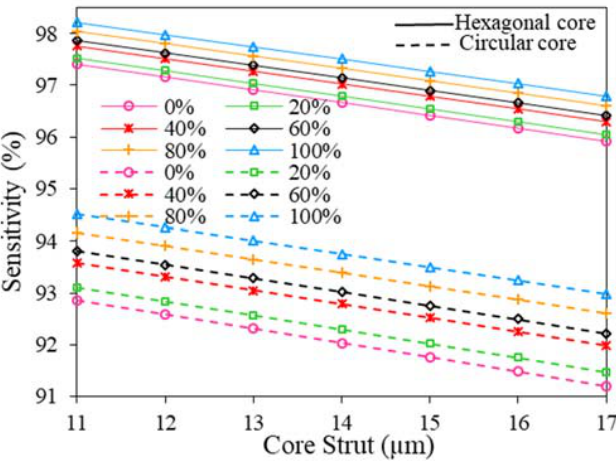
Table 2. RS of the proposed sensor with the variation of D, D c , and t for 100% Kerosene.